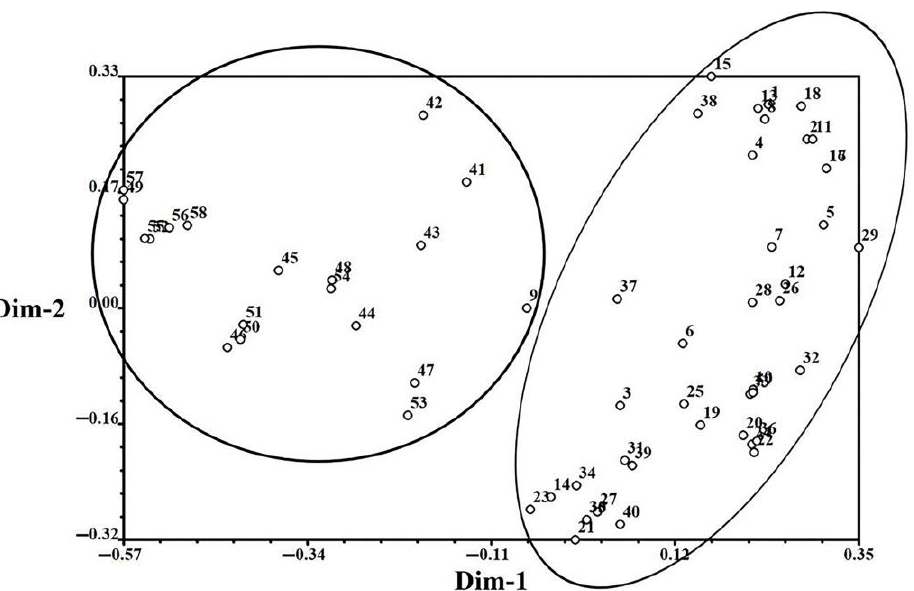
Figure 2. Results of STRUCTURE analysis for 59 populations using 14 EST-SSR markers: ( a ) Plot mean likelihood L(K) and variance per K value. ( b ) Plot of mean rate of change of the likelihood distribution L’(K) per K value. ( c ) Plot of absolute value of the second order rate of the change of the likelihood distribution |L’’(K)| per K value. ( d ) Estimation of population using Delta K value with cluster K ranging from 1 to 10. ( e ) Estimation of population structure based on STRUCTURE analysis.